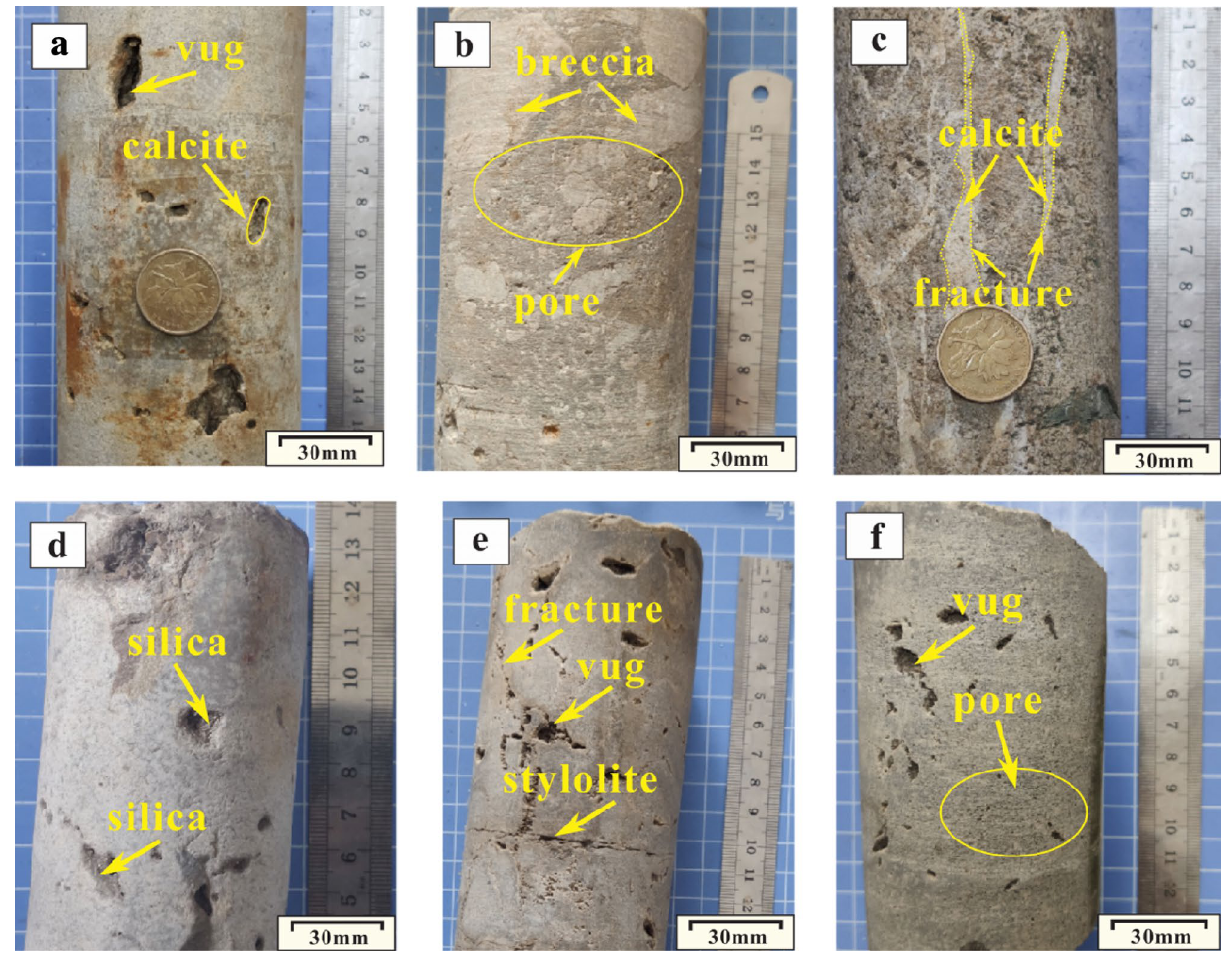
Figure 3. Photos of the Ordovician carbonate rocks and paleokarst: ( a ) Dolomitic limestones with vugs semi- filled with calcites, Well H1, 522.14 m; ( b ) Breccia limestones with pores, Well H6, 1367.50 m; ( c ) Argillaceous limestones with fractures fill-filled with calcites, Well H3, 1555.70 m; ( d ) Dolomites with vugs semi-filled with silica, Well F4, 1425.64 m; ( e ) Calcite dolomites with vugs, fractures and stylolites, Well F1, 672.05 m; ( f ) Argillaceous dolomites with vugs and pores, Well F3, 1236.50